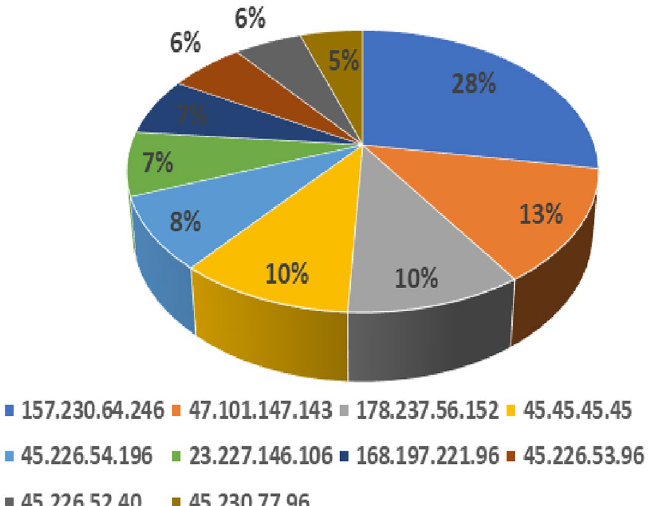
Figure 8. Attackers Source IP count percentage by Ddos honeypot.